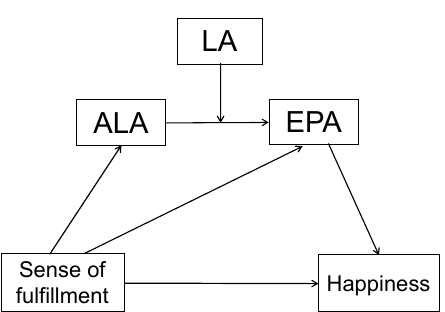
Figure 2. A mediation model to explore the underlying processes between a sense of fulfillment and happiness. This figure presents a hypothetical model based on existing research and statistical analysis: ALA oxidation by eustress, and an LA function that affects the conversion of ALA into EPA. LA did not show a significant effect on the conversion of ALA to EPA. No indirect effects from ‘a sense of fulfillment to SHS’ were significant. Only a direct effect of ‘a sense of fulfillment on SHS’ was significant ( p < 0.005) (age, BMI, menopause, snacking habits and leisure-time physical activities were adjusted as covariates).